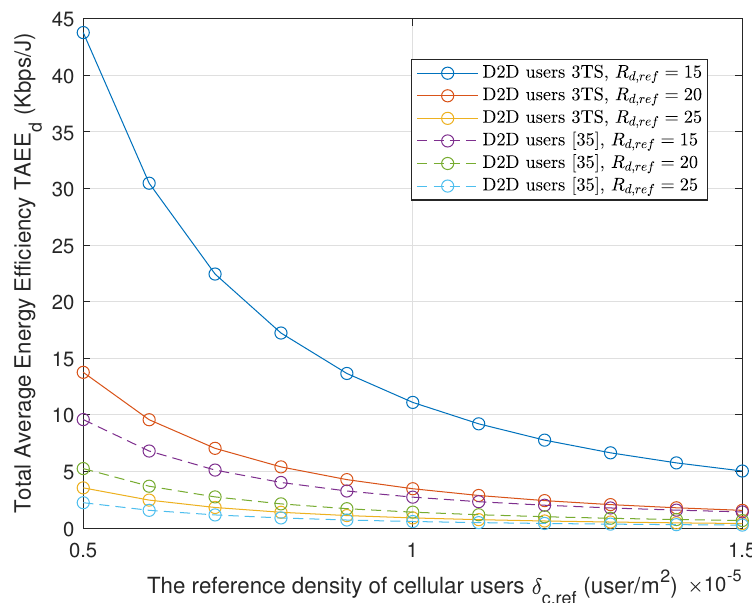
Figure 5. The TAEE of D2D communication in 3TS versus δ c , ref